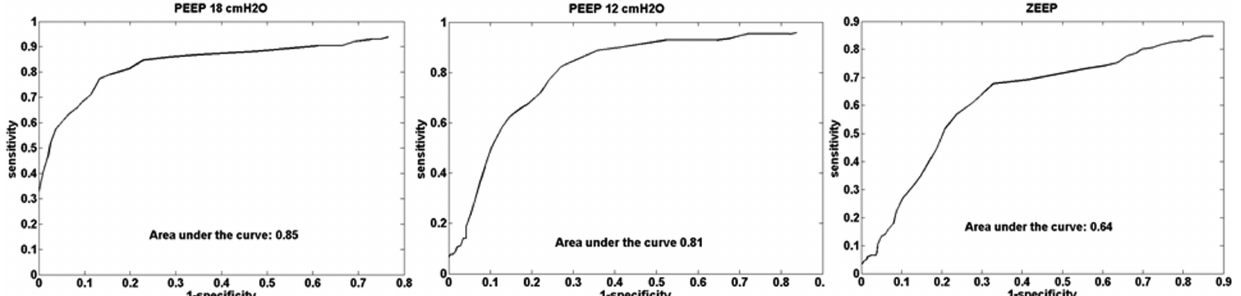
Figure 4 - ROC curve for lung perfusion map evaluation, for PEEP steps at 18 cm H